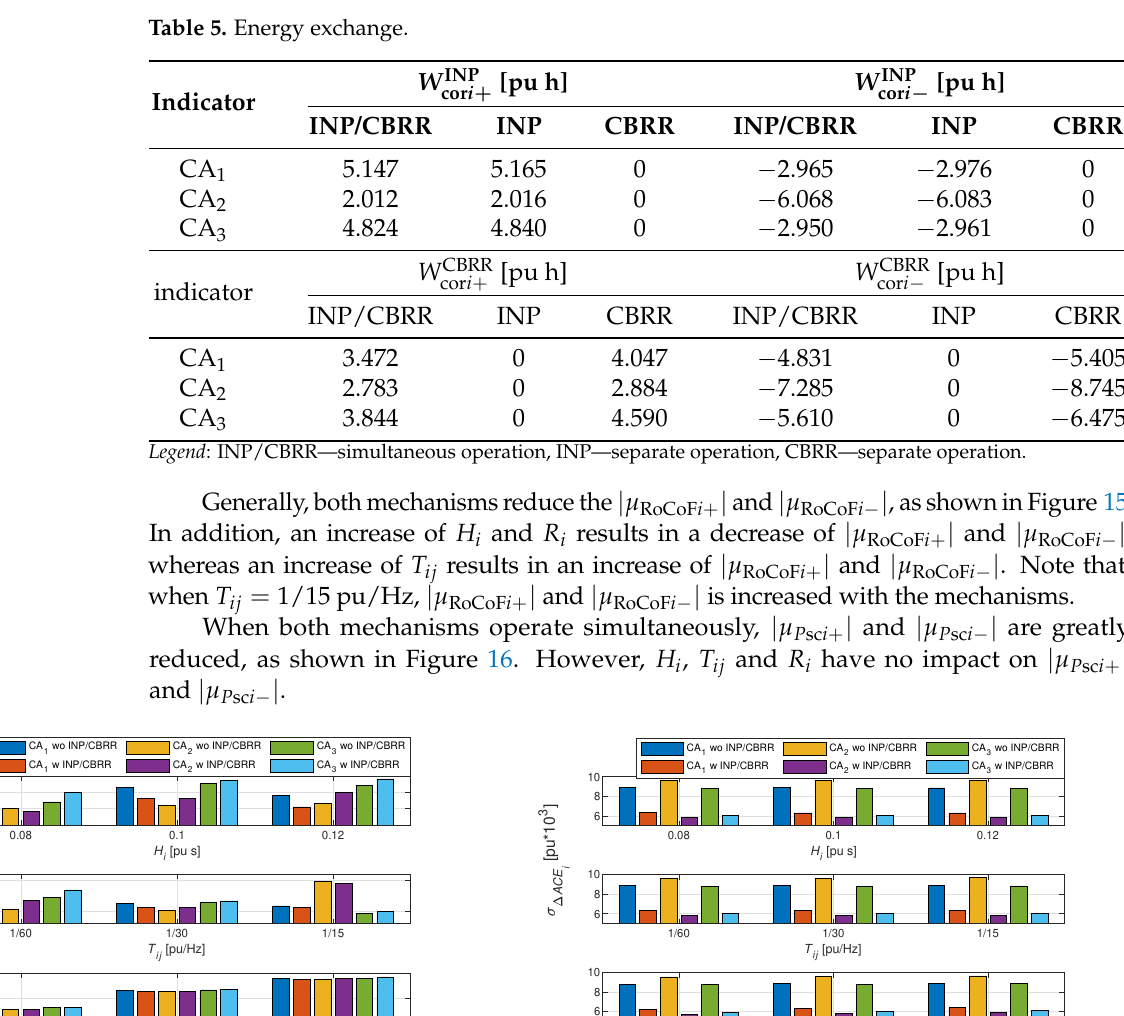
( right ) for different values of H i , T ij and R i , where “wo i